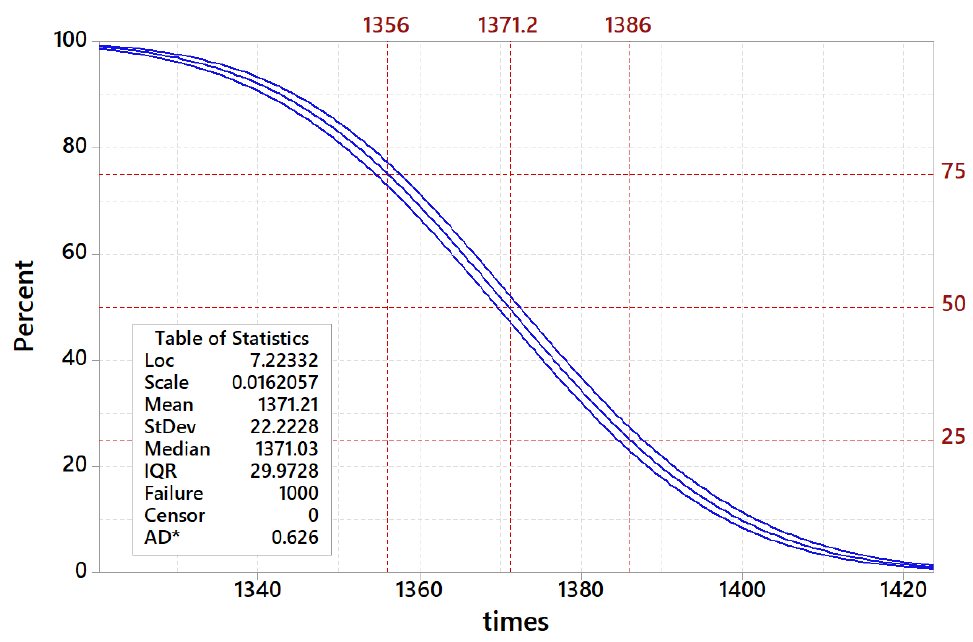
Figure 8. Survival function associated with the proposed solution (includes 95% confidence